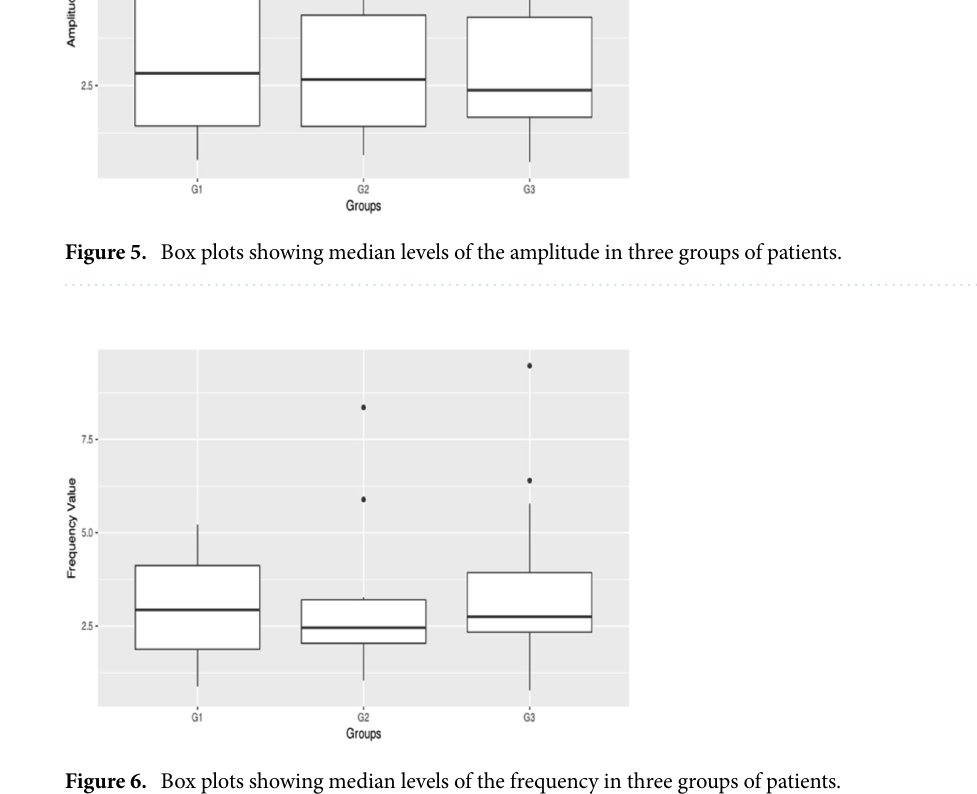
Figure 6. Box plots showing median levels of the frequency in three groups of